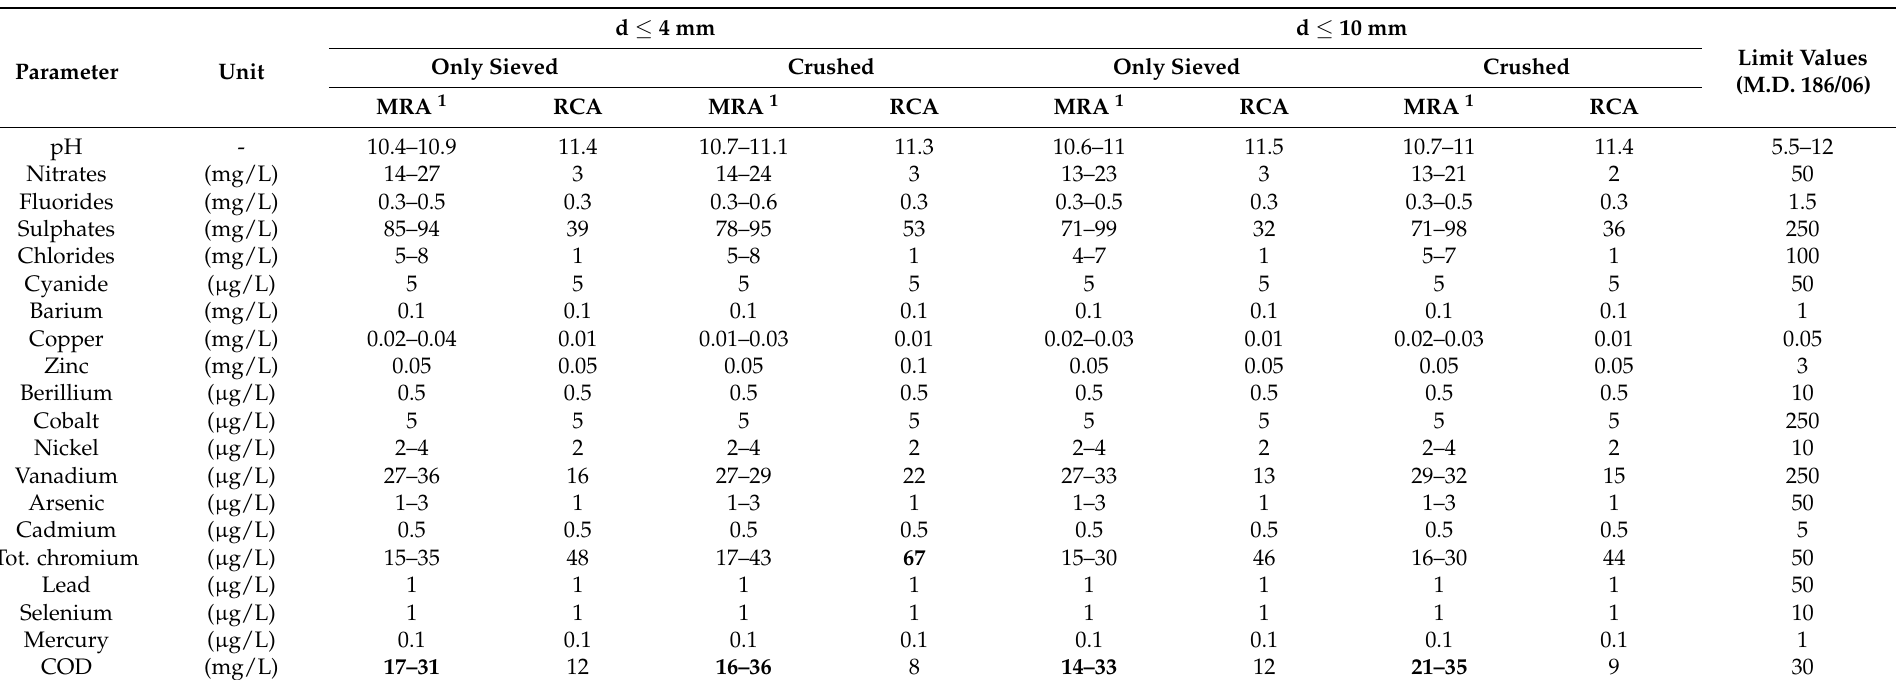
Table 5. Leaching behaviour of MRAs and RCAs tested according to the EN 12457-2 (d ≤ 4 mm) and EN 12457-4 (d ≤ 10 mm) methods, under conditions of only sieving and